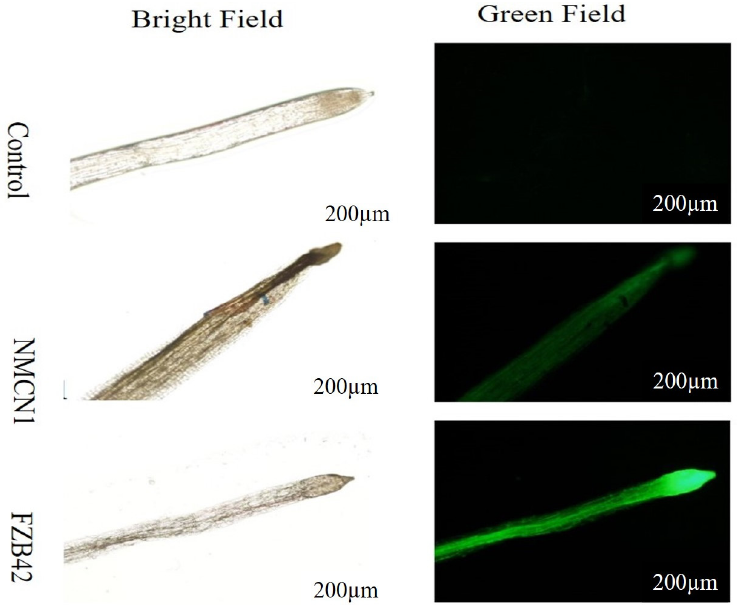
Figure 9. ROS reduction in wheat roots inoculated with Bacillus strains (NMCN1 and FZB42). The halophilic strains NMCN1 were found to highly reduced ROS in wheat roots and thus alleviate the risk of cell damage in roots. The experiment was repeated thrice with three